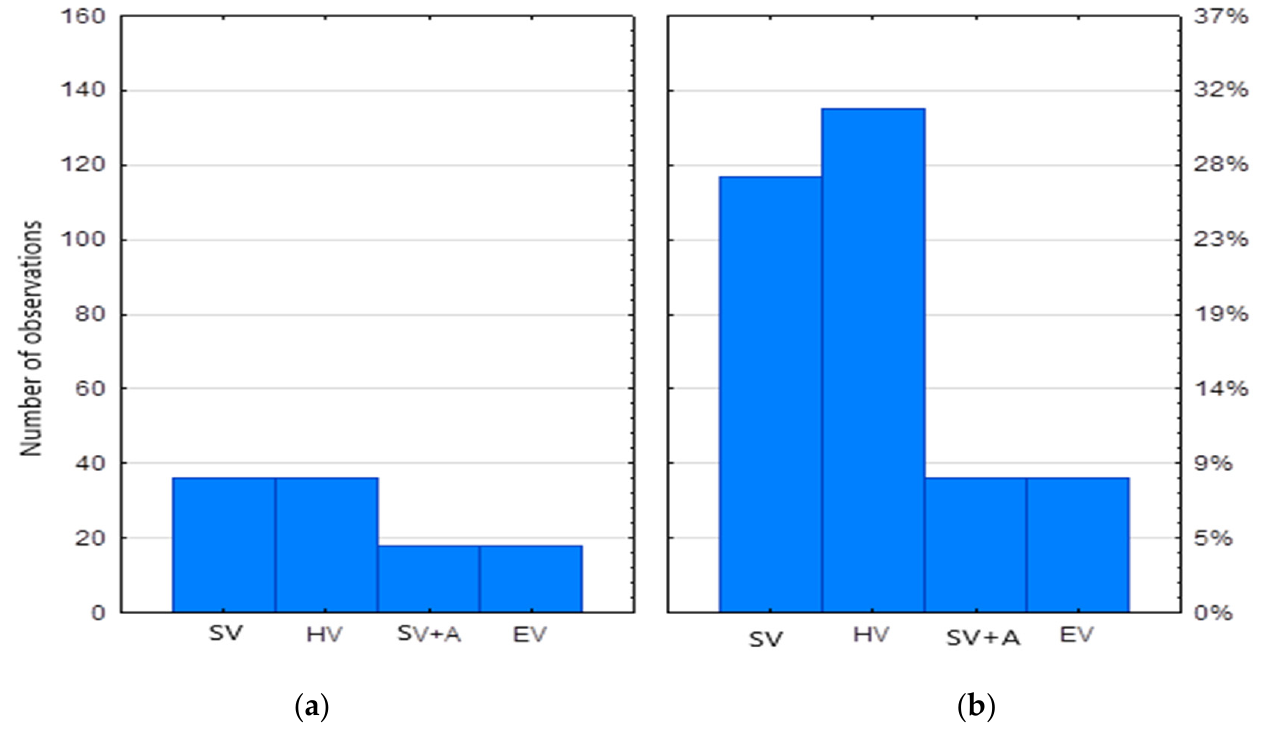
Figure 4. Popularity of car types by source of propulsion in the near future—analysis by the grouping variable “gender”: ( a ) Female; ( b ) Male.